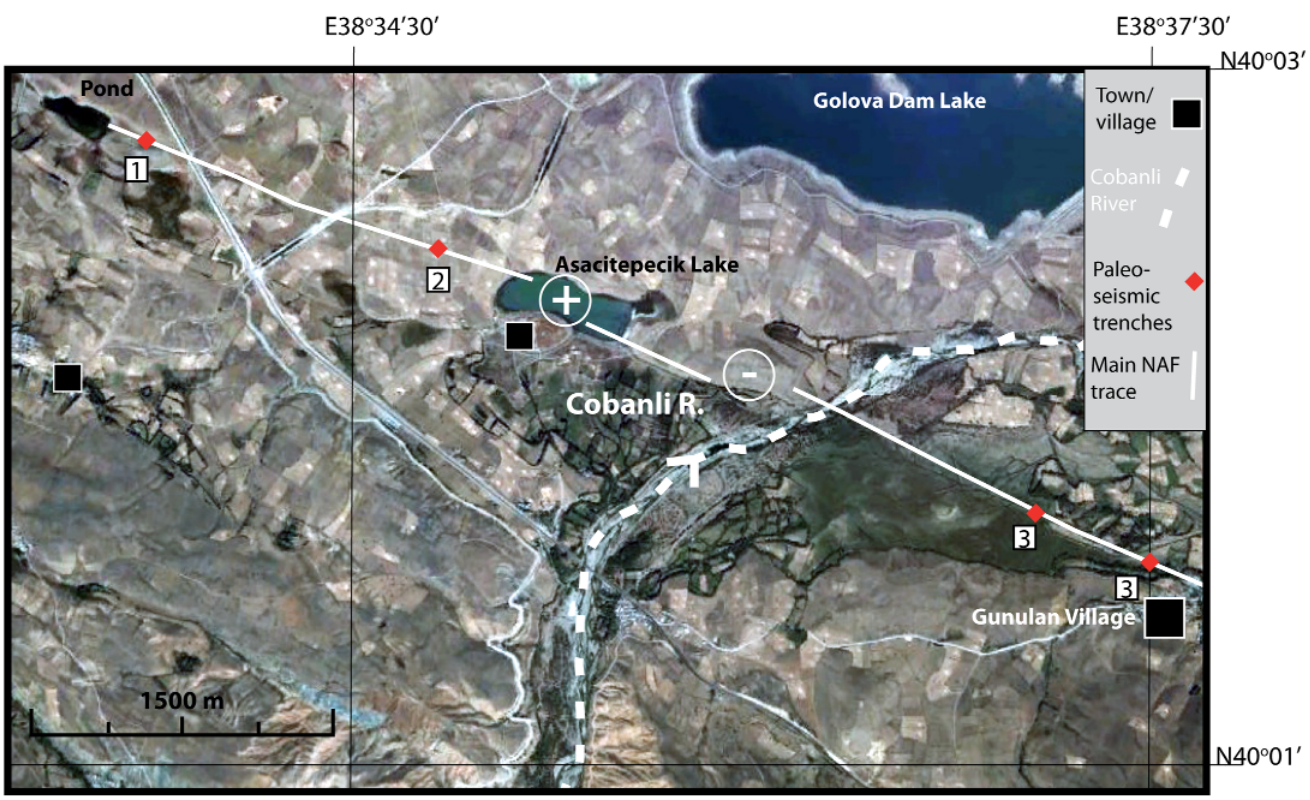
Figure 2. Relationships between A ş a ğ ıtepecik Lake and the NAF. The small depression filled by A ş a ğ ıtepecik Lake is located along a small releasing step. A minor restraining bend and the associated ridge are located to the SE of A ş a ğ ıtepecik Lake. Paleoseismological sites are indicated with red squares: 1 for Okomura et al. [1994]; 2 for Zabci et al. [2008]; 3 for Fraser et al. (this